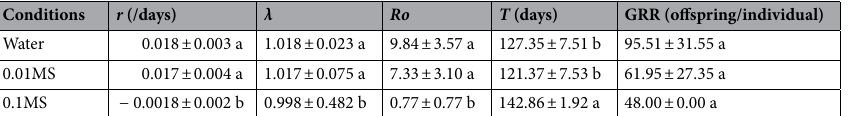
Table 3. Population parameters, including the intrinsic rate of increase ( r ), finite rate of increase ( λ ), net reproduction rate ( Ro ), mean generation time ( T ), and gross reproductive rate (GRR) of Acanthococcus lagerstroemiae under different nutrient conditions. Values are means ± standard errors; data within a column followed by different letters are significantly different at p < 0.05 by using paired bootstrap